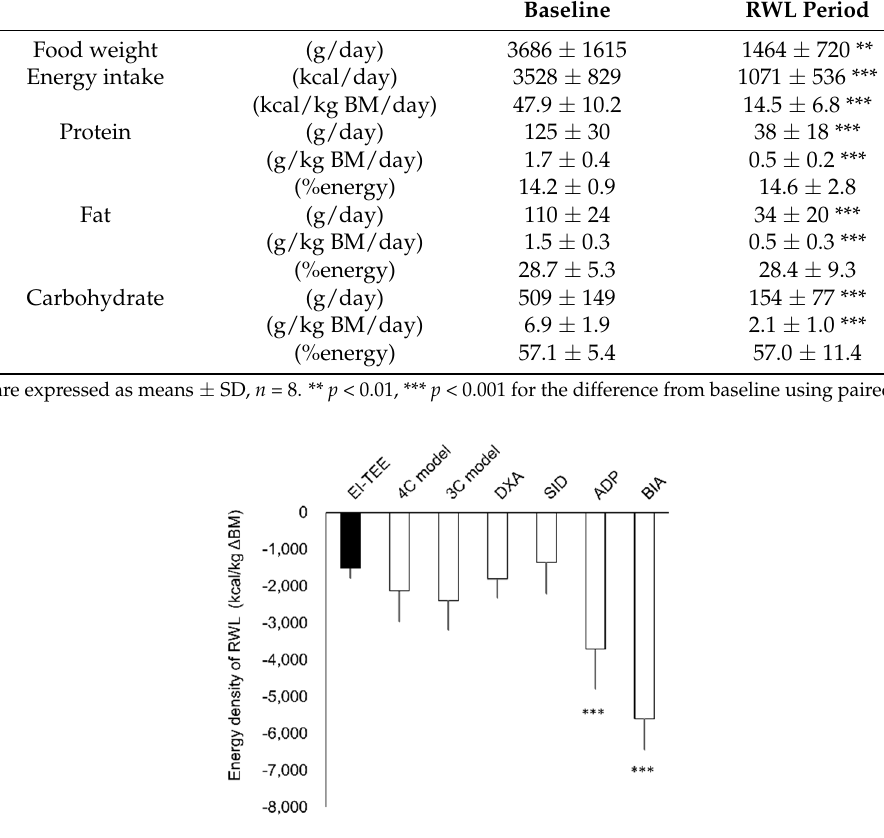
Figure 3. Energy density of rapid weight loss. Data are expressed as mean ± SD, n = 8. *** p < 0.001 vs. EI-TEE using Dunnett’s post-hoc test.